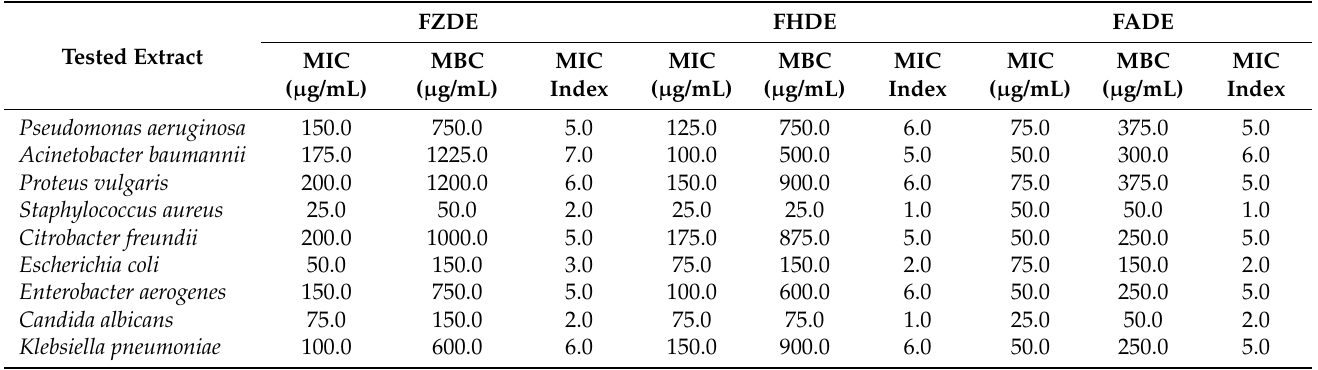
Table 3. MIC, MBC, and MIC indices of the most promising Egyptian date extracts.